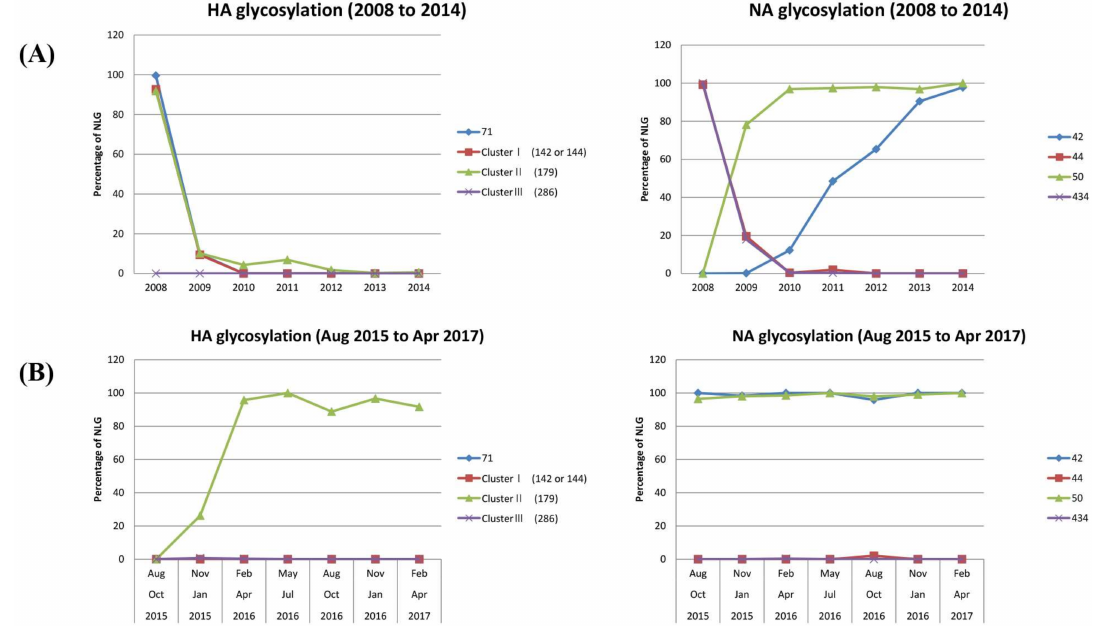
Figure 7. The temporal changes in glycosylation sites of H1N1 HA and NA among recent isolates. Major glycosylation sites were analyzed among influenza isolates from 2008 to 2014 in ( A ) and recently ( B ) (from August 2015 to April 2017): three clusters in HA and positions 44/50 in NA as signatures for pandemics and position 71 in HA and positions 42/434 in NA as characteristics for zoonotic (swine to human) transmission. Conserved glycosylation sites on HA and NA that are not related to pandemic or zoonotic transmissions are not